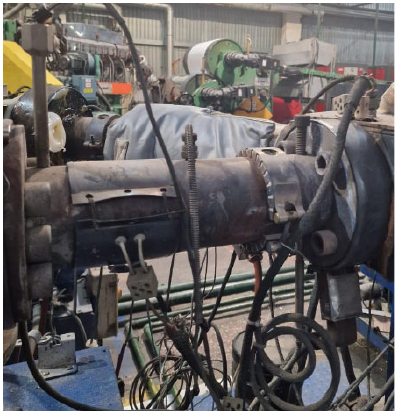
Figure 13. Material heating zone on the injection machine.